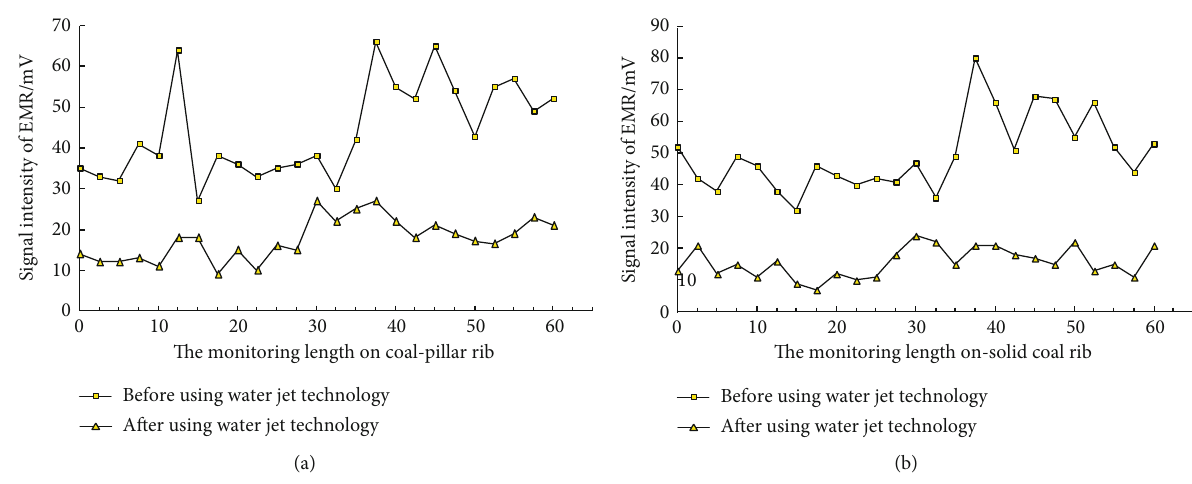
Figure 18: The monitoring result of signal intensity by EMR. (a) On solid-coal rib. (b) On coal-pillar rib.